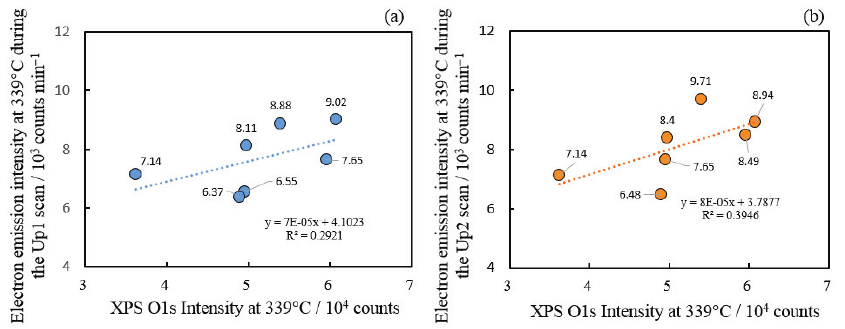
Figure 9. Plots of the electron emission intensity at 339 ° C during Up1 scan (a) and Up2 scan (b) against the XPS O 1 s intensity at 339 ° C for all scratching environments.